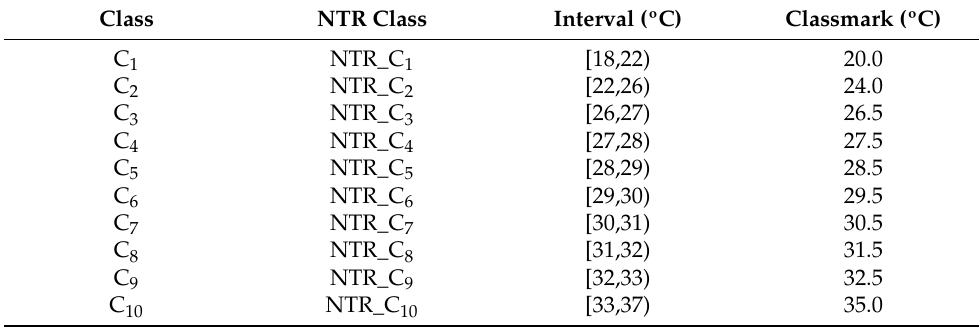
Table 2. Classes defined according to the temperature of the foot’s